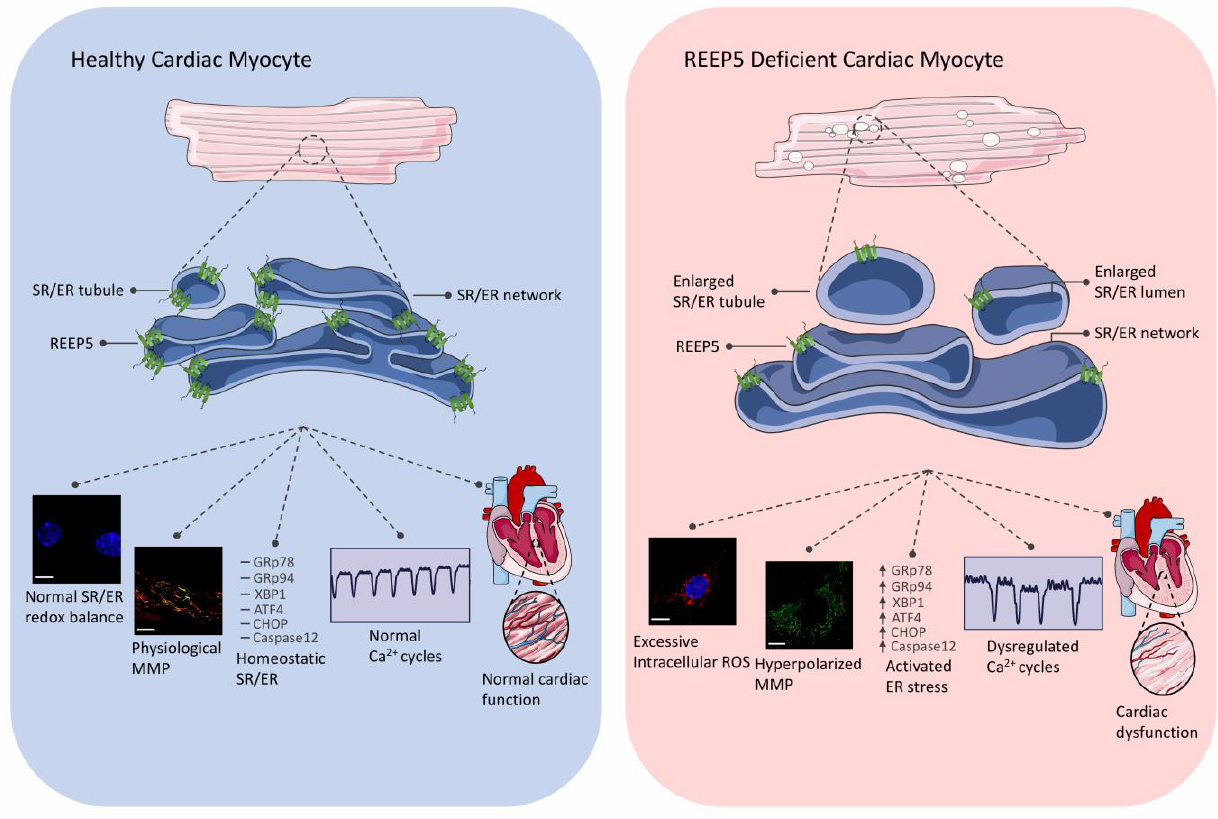
FIGURE 1: Summary of major functions of REEP5 in cardiac myocytes. REEP5 is a SR/ER membrane protein responsible for generating high membrane curvature to stabilize the highly differentiated SR network in cardiac myocytes. Normal expression of REEP5 under healthy physio- logical conditions (left) is required for proper formation, maintenance, and function of the SR/ER in the myocyte; loss of REEP5 (right) results in SR membrane vacuolization, excessive intracellular ROS, hyperpolarized mitochondrial membrane potential, activated ER stress pathways, dysregulated Ca 2+ cycles, and cardiac